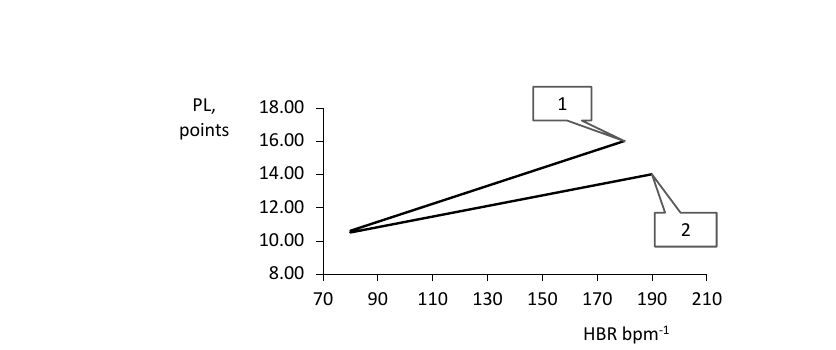
Fig.1. Regression equations of correlation of perceived load tension and heart beats rate: PL – perceived load value, points; HBR – heart beats rate, bpm -1 ; 1 – girl students: у=8.11+0.03х, where у is perceived load tension in points and х – frequency of heat beats rate, bpm -1 . 2- schoolgirls (12-13 years’ age): у=8.7+0.024х, where у is perceived load tension in points and х – frequency of heat beats rate, bpm -1